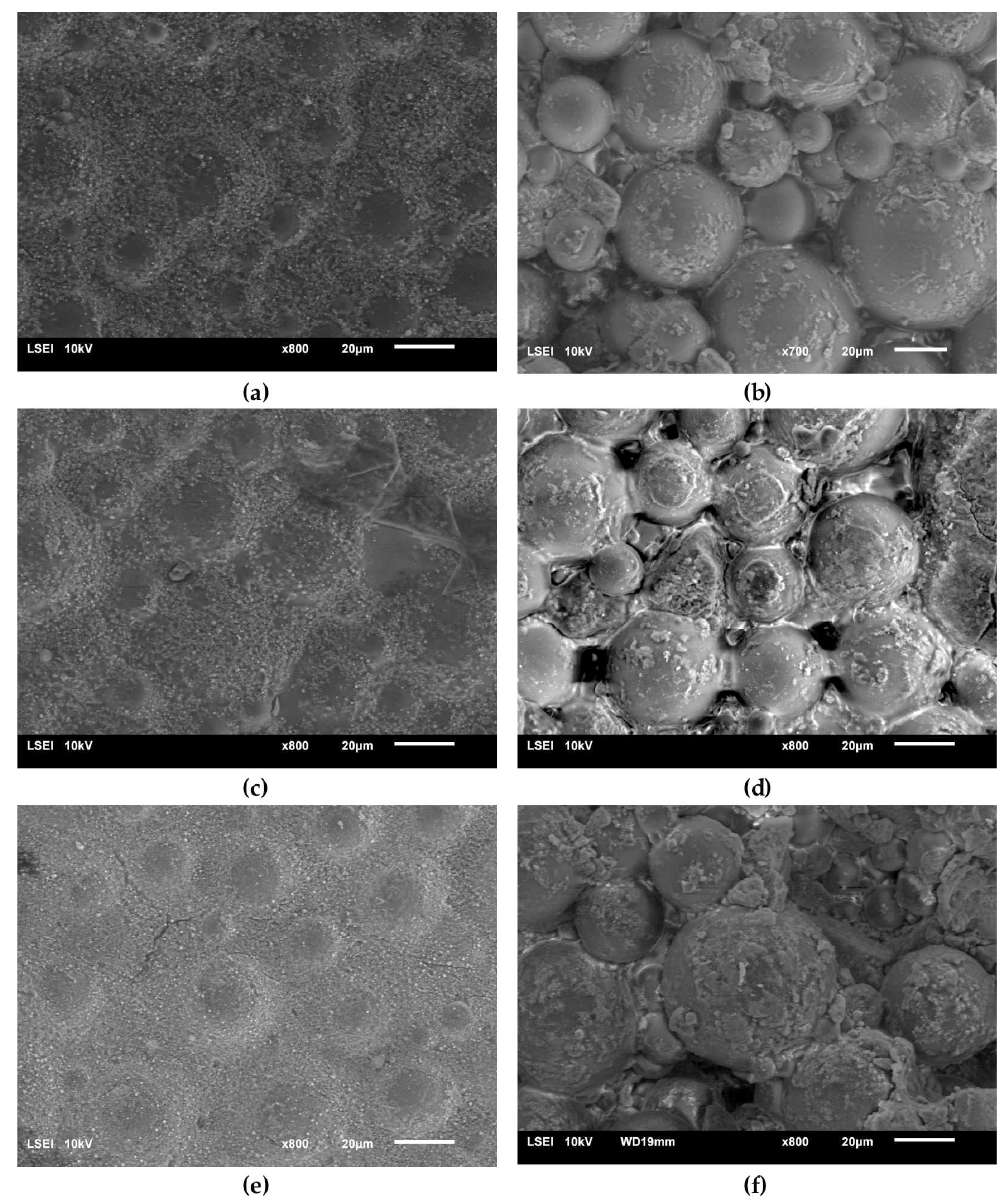
( b ), 12% nHAp / PAc ( c ), 12% µ HAp / PAc ( d ), 21% nHAp / PAc ( e ), and 21% µ HAp / PAc ( f Figure 9. Surface SEM micrographs of the bone cement samples: PAc, 6% nHAp/PAc ( a ), 6% µHAp/PAc ( b ), 12% nHAp/PAc ( c ), 12% µHAp/PAc ( d ), 21% nHAp/PAc ( e ), and 21% µHAp/PAc ( f ).